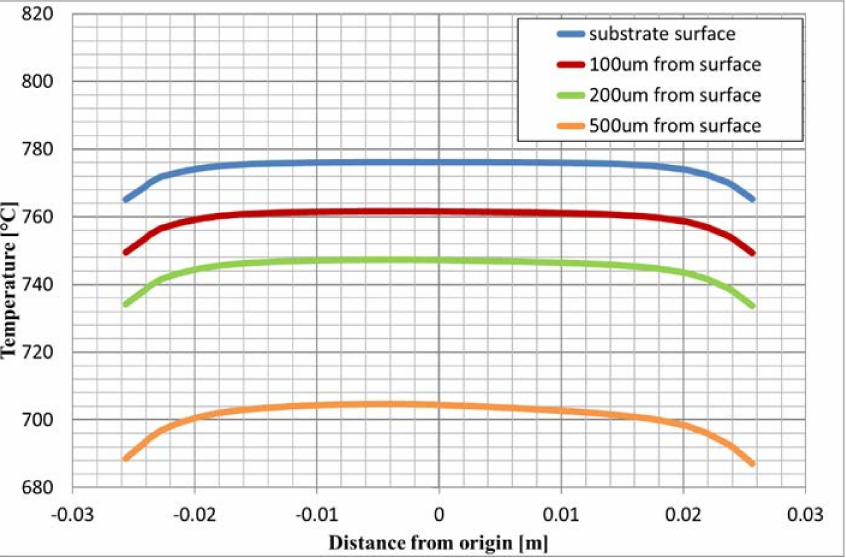
Figure 4. The temperature distribution along the substrate surface diameter, and at 100 µ m, 200 µ m, and 500 µ m from it, obtained at the pressure of 0.5